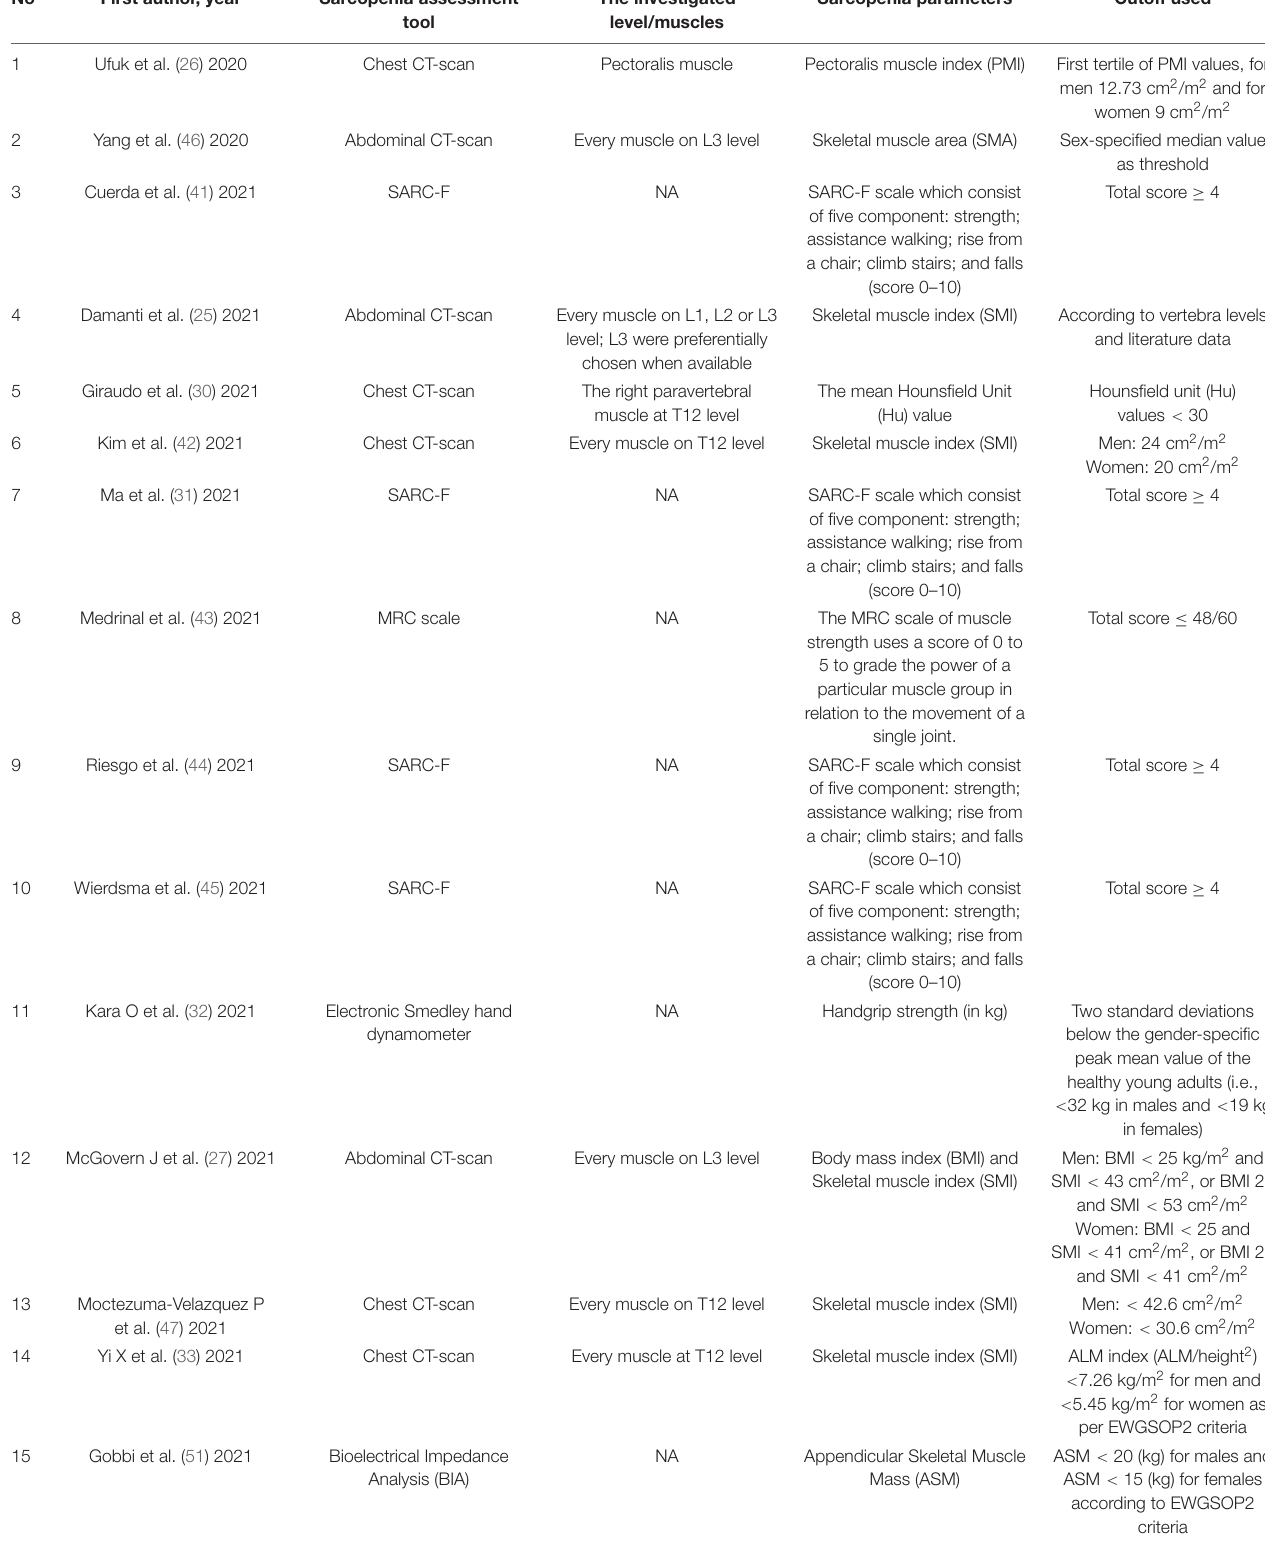
TABLE 2 | Sarcopenia diagnosis and their parameters with cutoff values used in the included